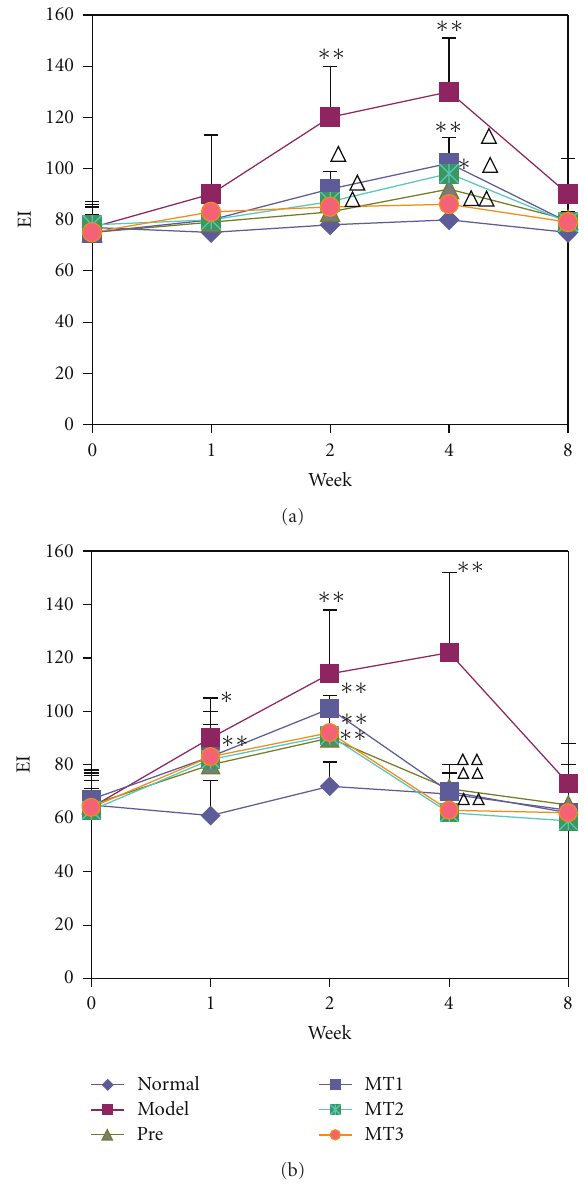
Figure 1: The sera of mice in each group were collected before treatment (0), 2, 4, and 8 weeks later, and levels of IgM anti- ssDNA and Antihistone antibodies were detected by ELISA. EI was calculated according to the formula. (a) the level of IgM anti-ssDNA antibody in each group, (b) the level of IgM Antihistone antibody in each group. Data were given in mean ± SD ( n = 6–8). ∗ P < . 05, ∗∗ P < . 01 versus sera at 0wk, (cid:2) P < . 05, (cid:2)(cid:2) P < . 01 versus sera in model control